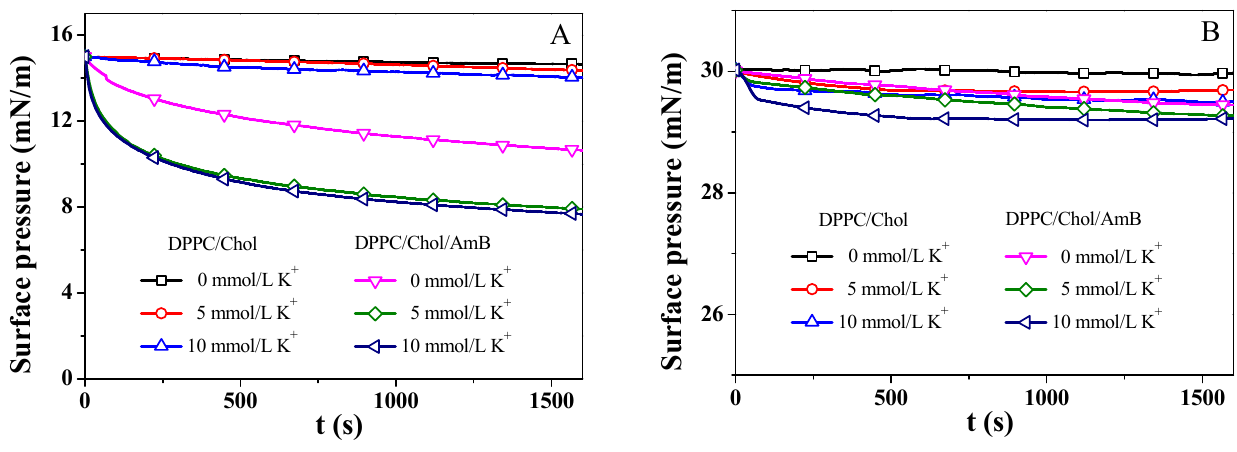
Figure 4. The surface pressure–time ( π -t) curves of the DPPC/Chol mixed monolayer and the DPPC/Chol/AmB mixed monolayer at the air–water interface in the absence and presence of potassium ions (5 mmol/L and 10 mmol/L) at 15 mN/m ( A ) and 30 mN/m ( B ).